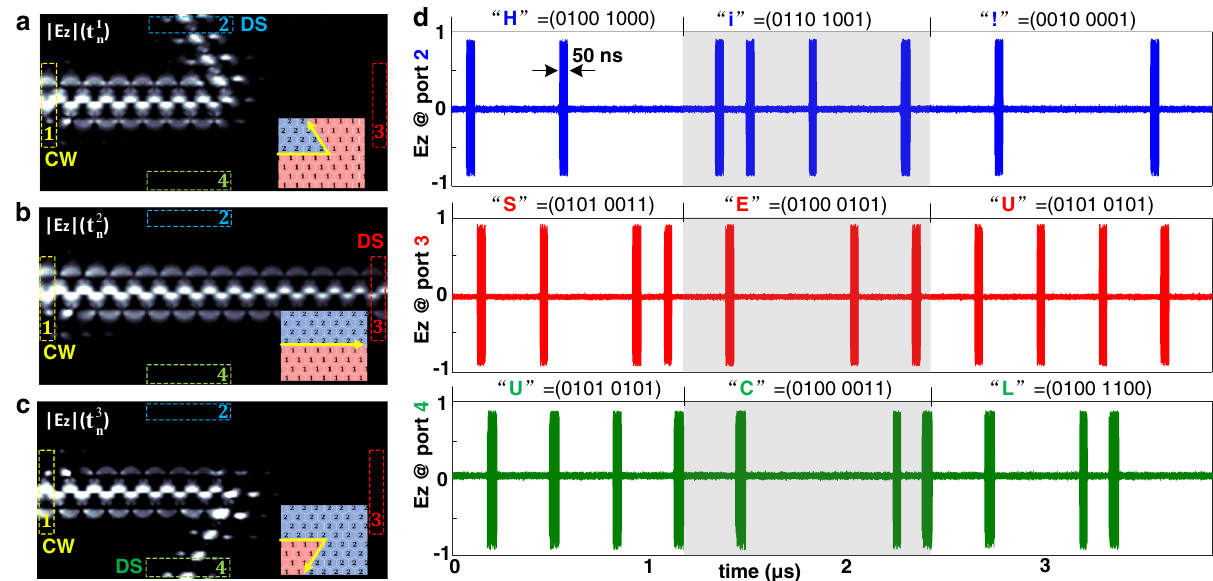
Fig. 4 Proof-of-principle experiment of a reprogrammable multi-channel optical analog-digital converter. a – c Encoded propagation routes and the corresponding simulated fi eld distributions of |E z | as a function of time tn. Here, t n 1 = t 0 + 3 n Δ t , t n 2 = t 0 + (3 n + 1) Δ t , and t n 3 = t 0 + (3 n + 2) Δ t , where n = 0,1,2,3, … , Δ t is the switching period, and t 0 is the start time of the coding. A continuous wave (CW) is pumped at the input port 1. Because of the high- speed switching of topological propagation routes, the input CW is modulated directly as a digital signal (DS) detected at the output port. d Measured output signal of each port. Three ASCII sequences (i.e. “ Hi! ” , “ SEU ” , “ UCL ” ) are modulated and transmitted in our RPTI, and the switching time of topological propagation route can be as short as 50